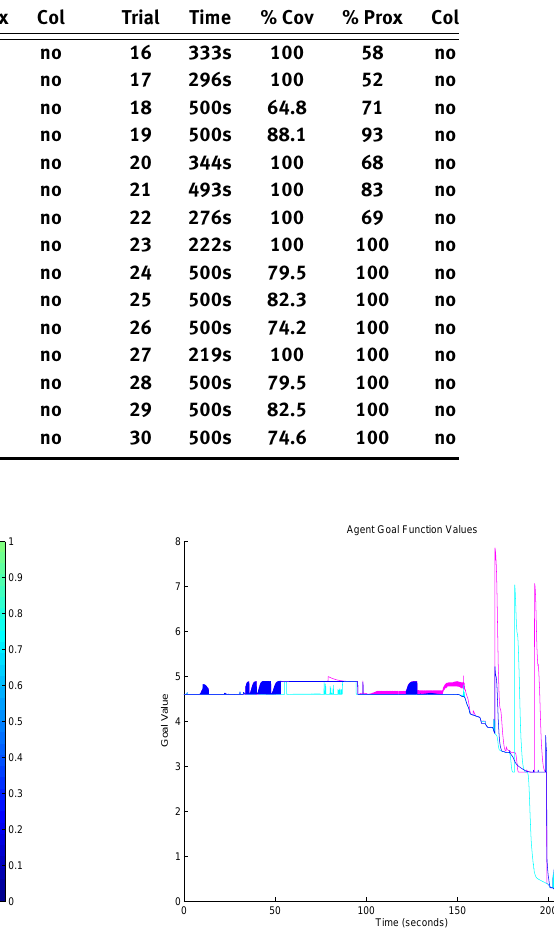
Fig. 7. Robot goal functions versus